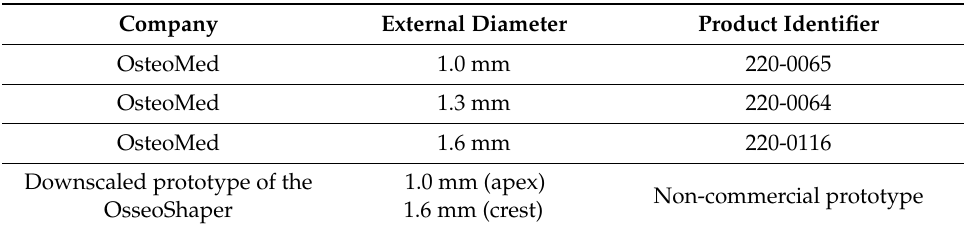
Table 1. Surgical drill